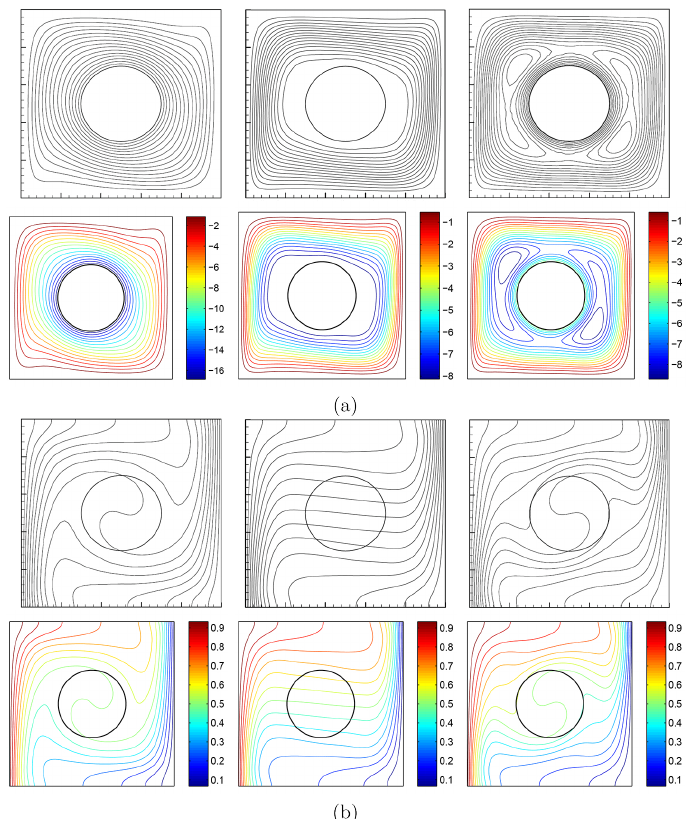
Figure 2. Comparisons between the results of ( top ) Costa and Raimundo [13] and ( bottom ) the present work for Ω = − 500 ( left ), Ω = 0 ( middle ), and Ω = 500 ( right ) of streamlines ( a ) and isotherms ( b ) at Ra = 10 5 , N = 0, K r = 1, R = 0.2, and Pr = 0.7.